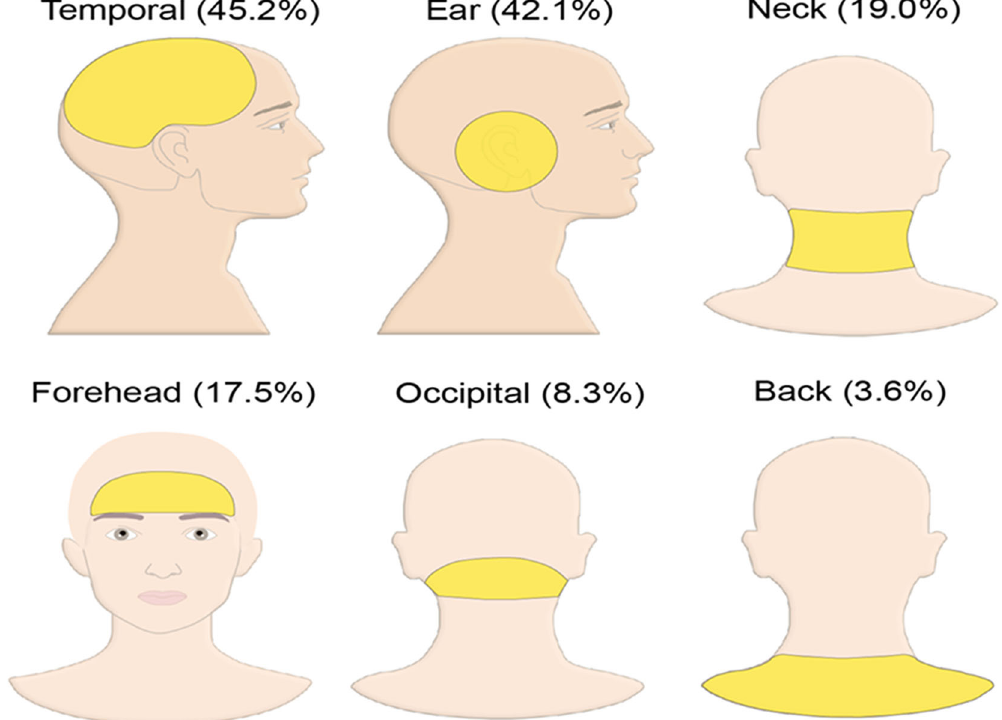
Figure 1. Prevalence of referred pain at different